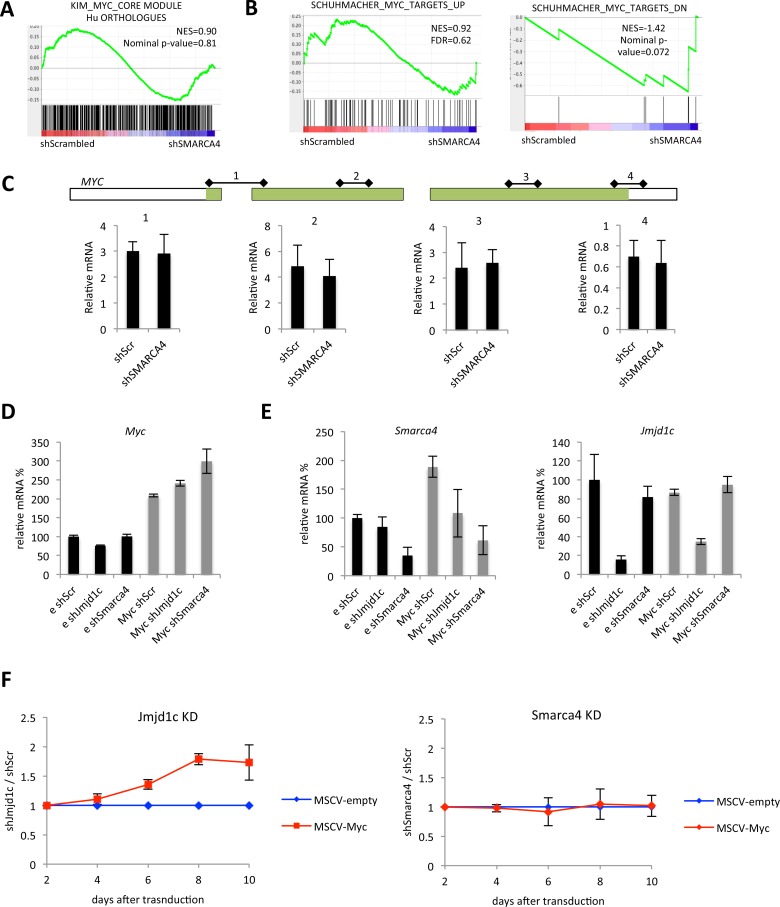
No changes in MYC expression after SMARCA4 knockdown.(A-B) GSEA plots showing enrichment of the indicated gene sets in genes ranked by Signal2noise metric in SMARCA4 knockdown versus control THP-1 cells. (C) Top: schematic representation of the human MYC locus; coding sequence is marked in green; qPCR primer pairs and their amplification products are represented as regions 1–4. Bottom: Relative mRNA levels of MYC assessed by using the indicated primer pairs. (D-F) Myc rescue experiments of Smarca4 and Jmjd1c KD in MLL-AF9 cells. (D-E) Relative mRNA levels of the indicated genes in cells transduced with the indicated combinations of vectors. e, empty vector; Myc, Myc expression vector; shScr, non-targeting control pMLS-YFP vector; shJmjd1c and shSmarca4, pMLS-YFP vectors targeting Jmjd1c and Smarca4, respectively. (F) Normalised ratios of GFP+ YFP+ cell percentages between shJmjd1c and shScr samples (left) or shSmarca4 and shScr samples (right) plotted over an 8-day time course starting from day 2 after transduction.